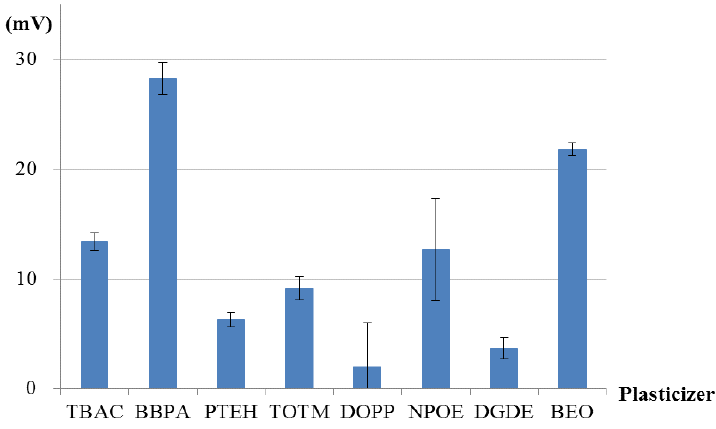
Figure 8. The responsivity in terms of CPA values of the membranes comprising PAEE, PVC and one of the eight types of plasticizer to 10 mM aspartame. Aspartame sample was measured using 8 kinds of lipid/polymer membrane (parameter: type of